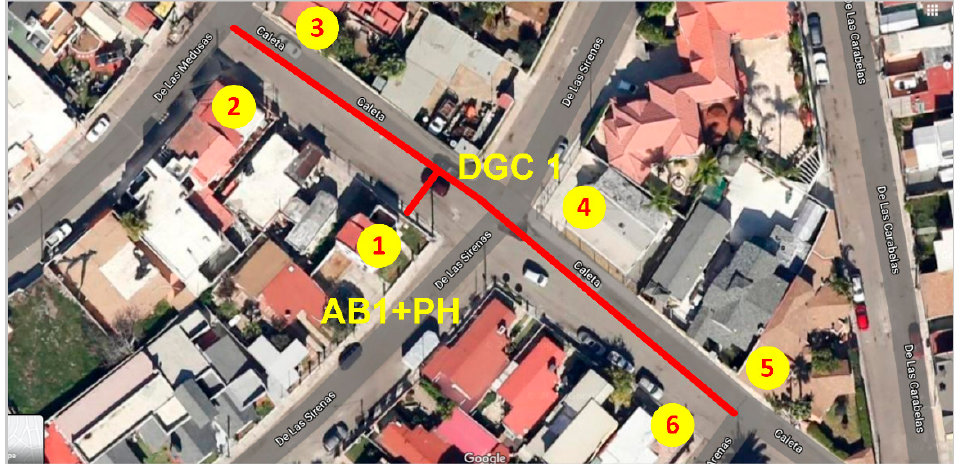
Figure 4. Location of the DGC 1 as well as the active building 1 that meets the Passivhaus criteria shown in Table 3. The solid red line represents overhead electrical wiring. Adapted from Google Maps, 2021.